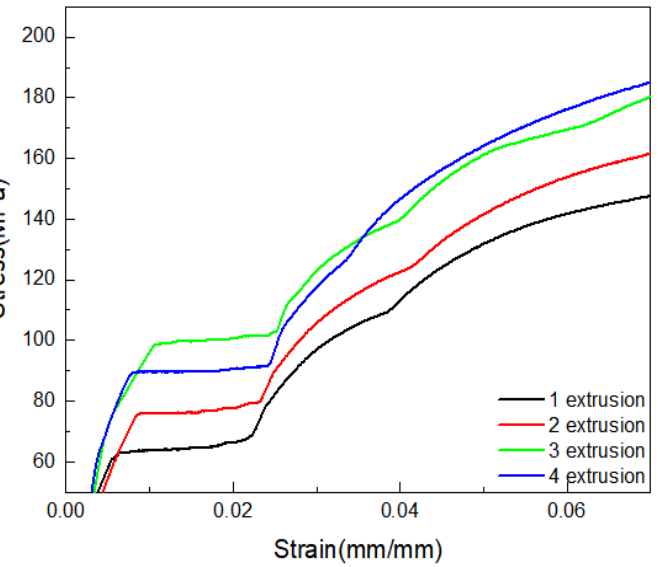
Figure 15. Stress–strain curves of tensile properties of 10 vol.% HEA composites at room temperature (26 °C) with different extrusion passes.